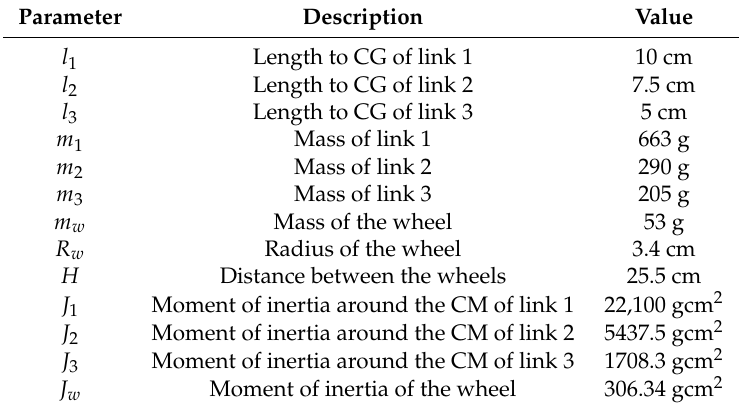
Table 1. Mobile robot